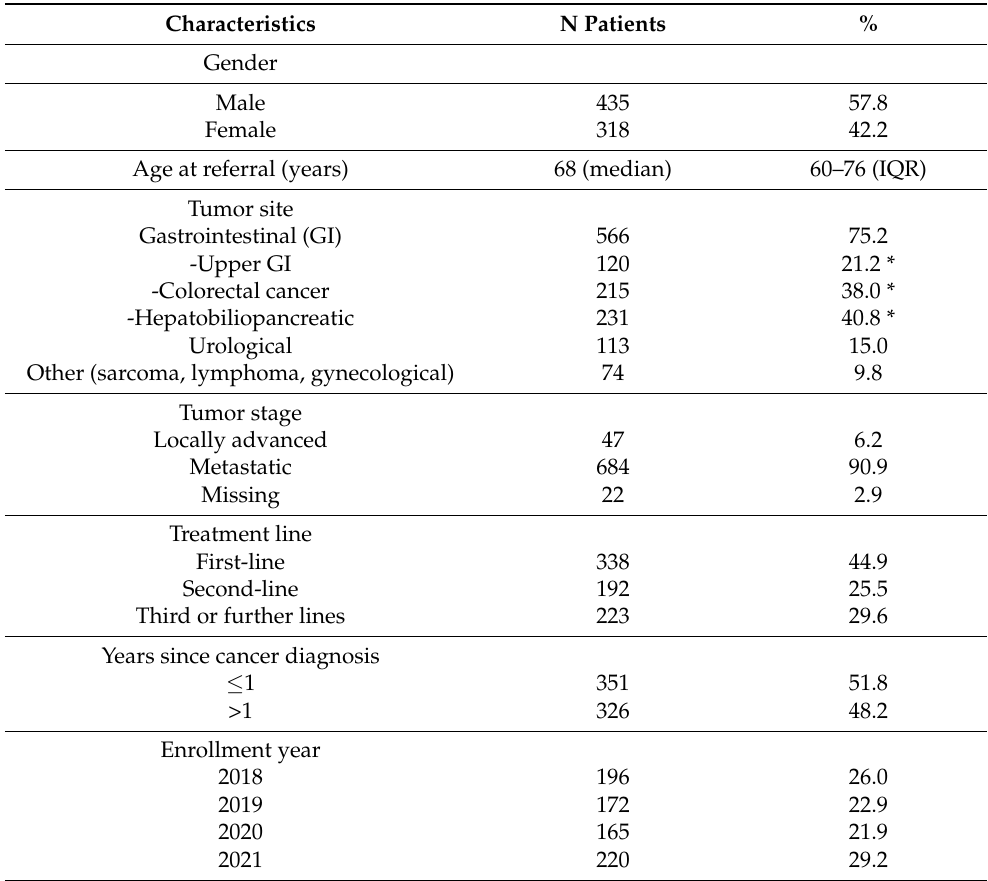
Table 1. Patients’